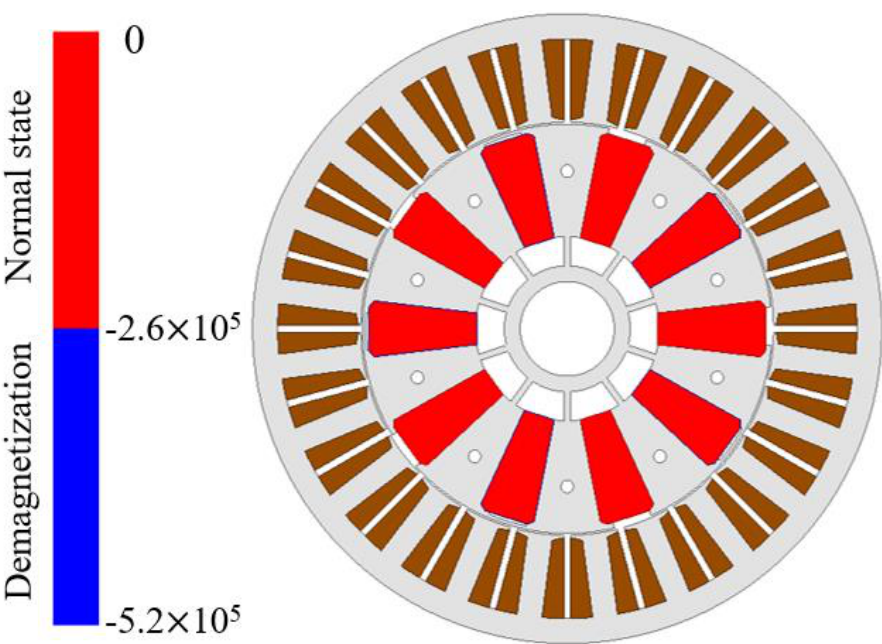
Figure 16. Final model irreversible demagnetization FEA analysis result.